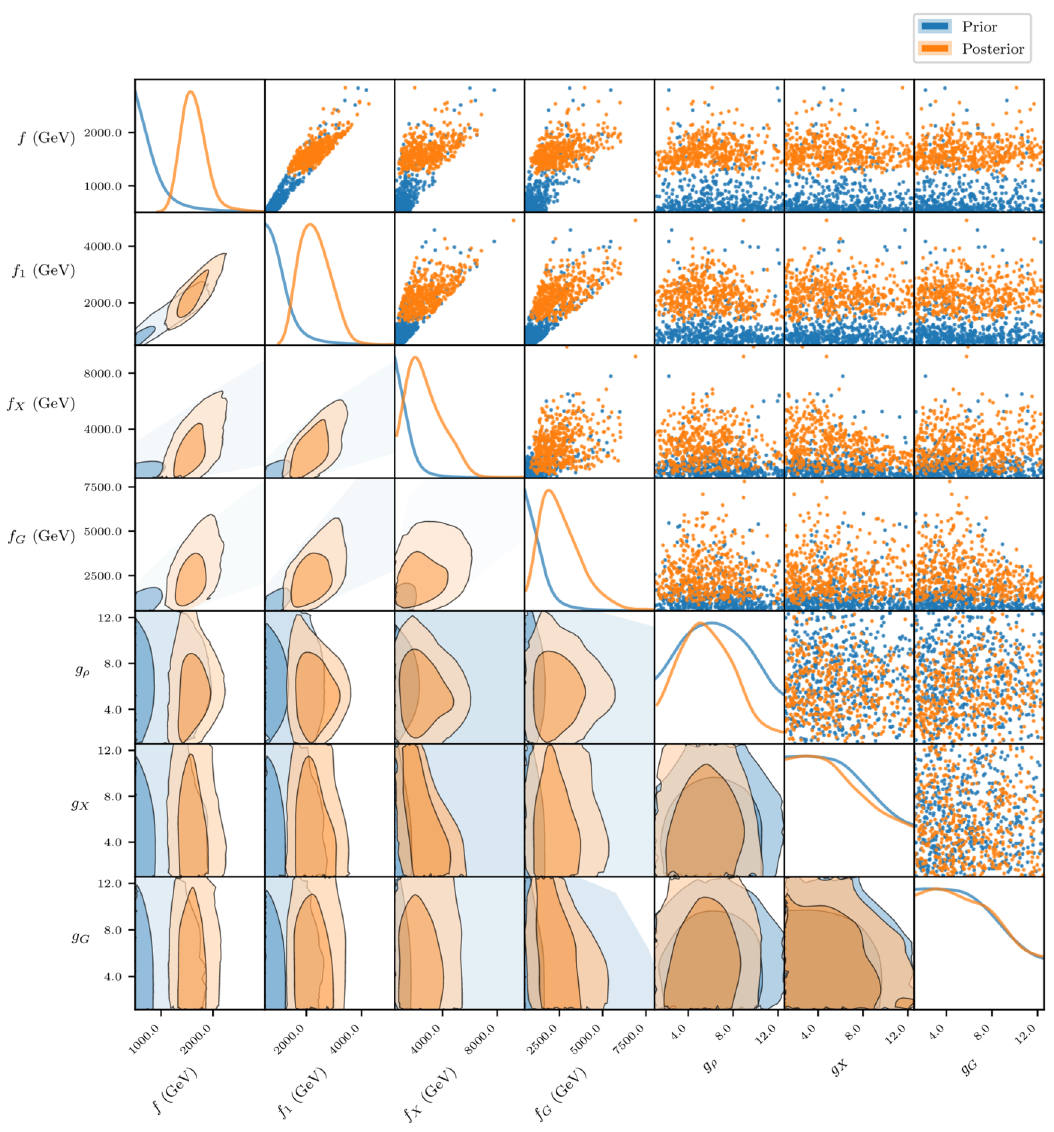
Figure 8. 1D and 2D marginalised priors and posteriors for the gauge sector parameters in the M4DCHM 14 − 1 − 10